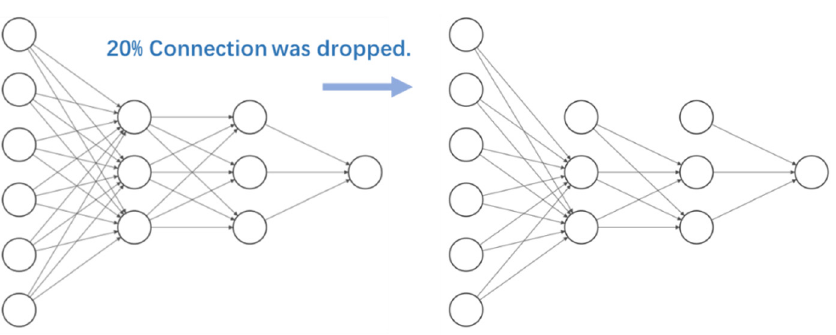
Figure 14. Dropout method, randomly removing the connection between nodes.